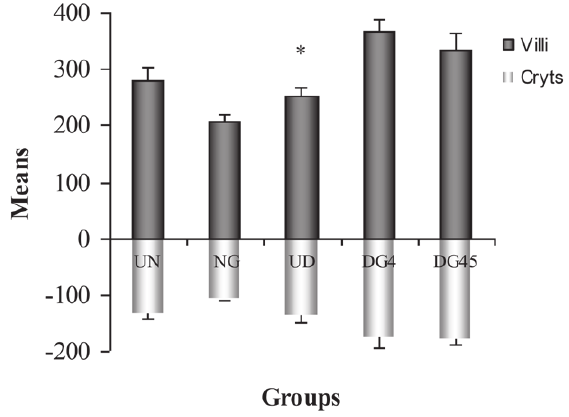
Figure 5 - villi height (µm) and crypts depth (µm) in the ileum mucosa of untreated normoglycaemic rats (UN), L-glutamine- treated normoglycaemic (NG), untreated diabetic (UD), L-glutamine-treated diabetic (DG4) and (DG45). All results were shown as means ± standard error. n = 5 rats per group. * P < 0.05 when compared to group